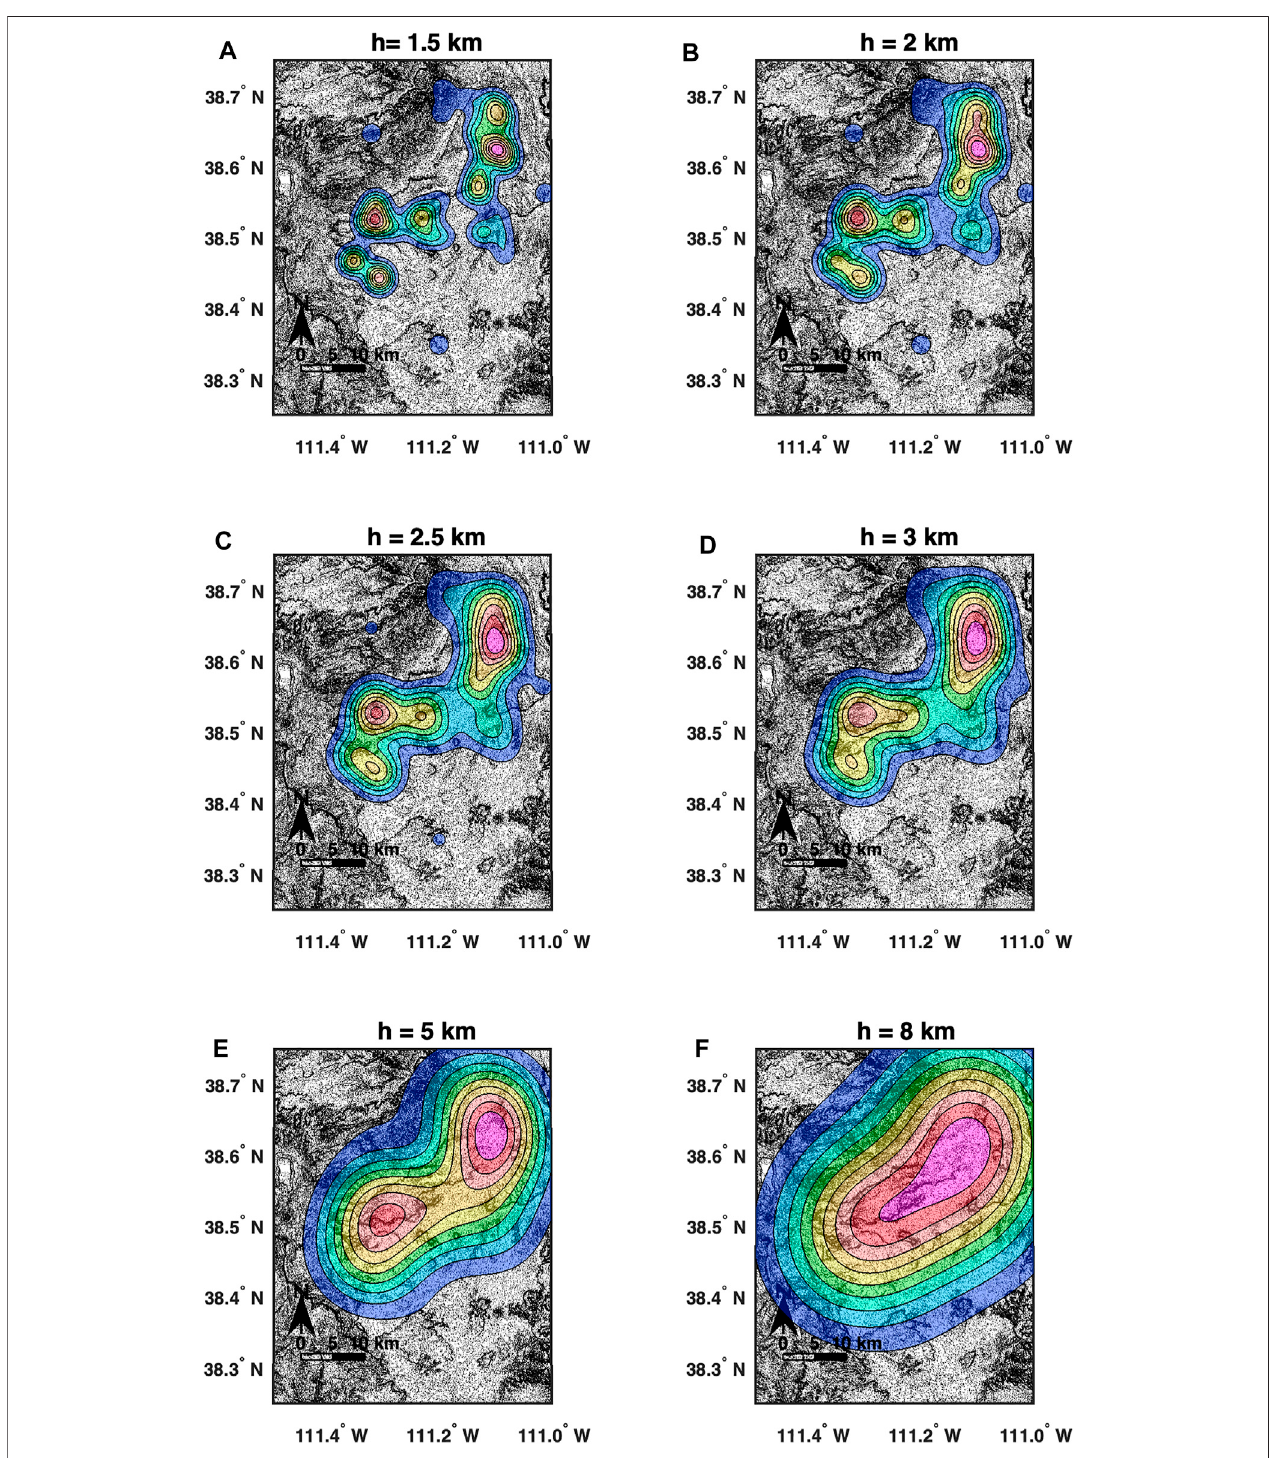
FIGURE 7 | Sequence of PDFs used for exploration of the main features of the PDFs associated with the vent distribution of vents on the San Rafael area.